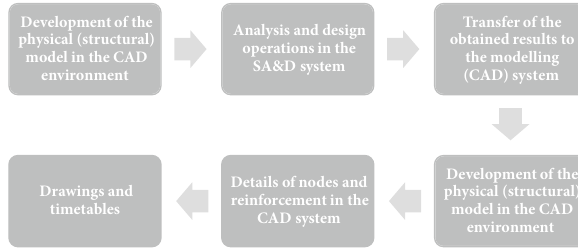
Figure 4. An alternative design process showing the analysis model developed separately from the physical building